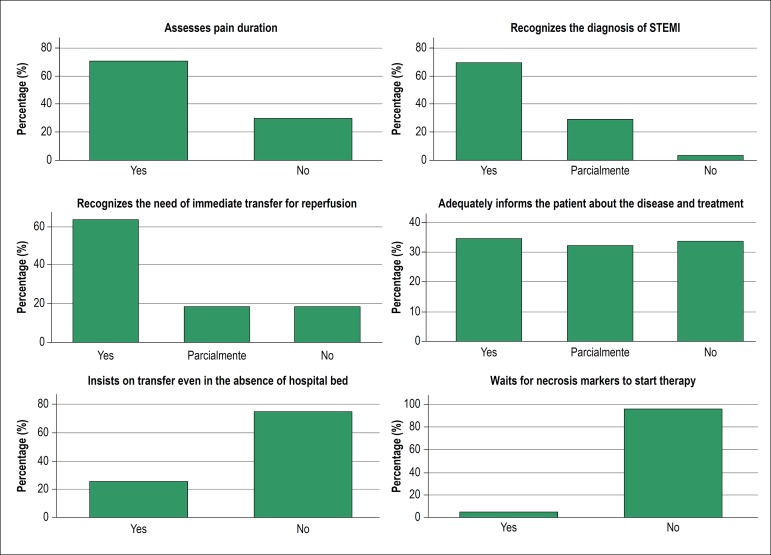
Bars graph showing performance of recently graduated physicians in each of the six items of the checklist directly related to diagnosis and management of the patient’s tranfer during practical evaluation in the simulated station of STEMI medical care.